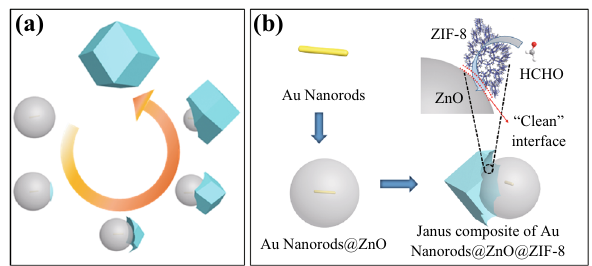
Fig. 1 a Schematic illustration for the anisotropic synthesis of Au NRs@ZnO@ZIF-8, with the selective detection of HCHO highlighted